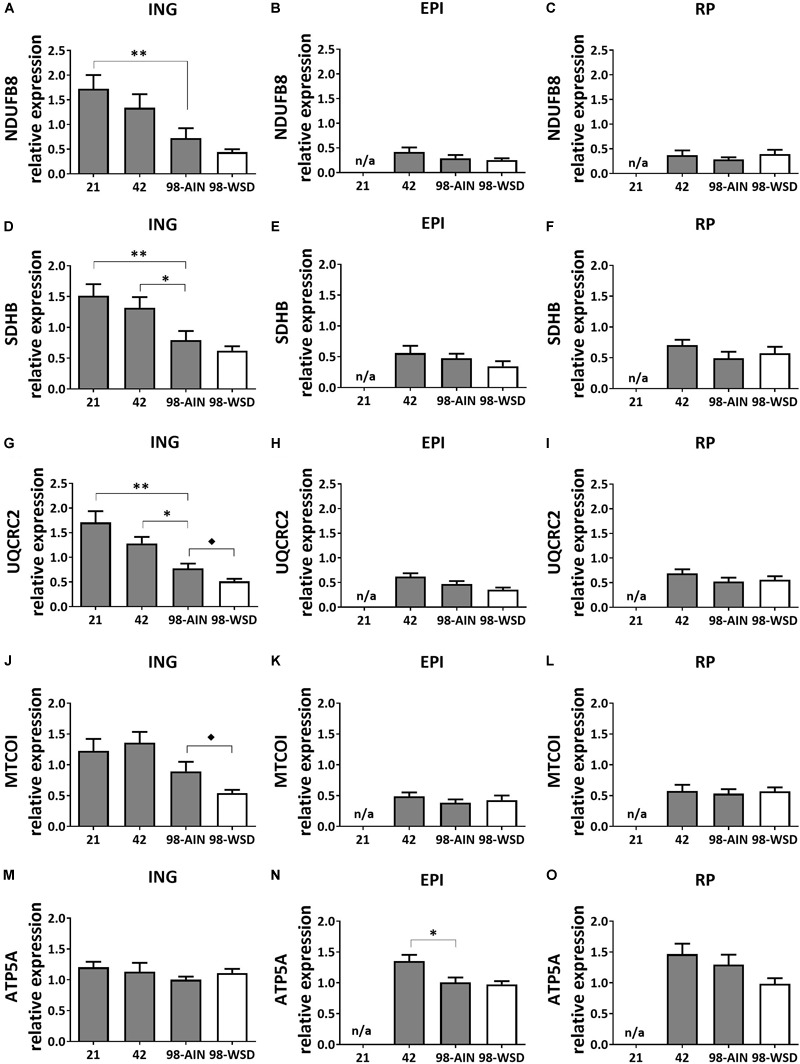
Changes in protein levels of subunits of oxidative phosphorylation complexes I-V between PN21 and PN98. NDUFB8 (Complex I) levels in (A) ING WAT, (B) EPI WAT, (C) RP WAT; SDHB (complex II) levels in (D) ING WAT, (E) EPI WAT, (F) RP WAT; UQCRC2 (complex III) levels in (G) ING WAT, (H) EPI WAT, (I) RP WAT; MTCOI (complex IV) levels in (J) ING WAT, (K) EPI WAT, (L) RP WAT; ATP5A (complex V) levels in (M) ING WAT, (N) EPI WAT, and (O) RP WAT. PN, postnatal day; AIN, AIM93-M diet; WSD, western style diet. Data expressed as mean expression levels corrected for total protein expression (Coomassie staining) + SEM, n = 8 for PN 21 and PN42 and n = 11 for PN98, no data available (n/a) for EPI and RP WAT at PN21. Time and WSD effects were analyzed separately; time effect: ∗p < 0.05; ∗∗p < 0.01; WSD effect: ◆p < 0.05.